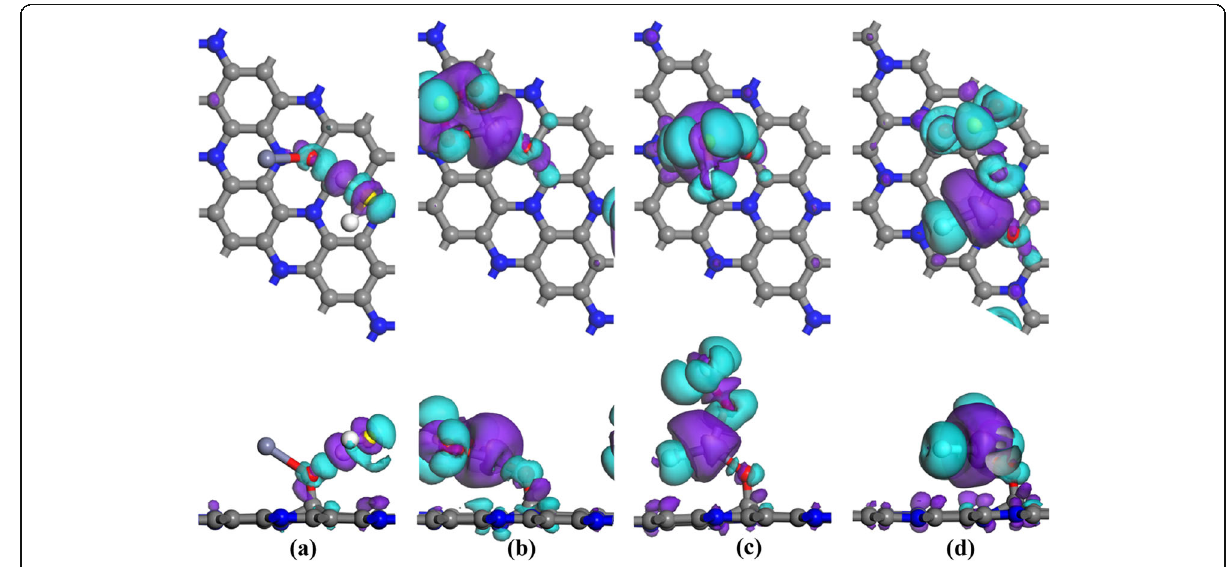
Fig. 5 The EDD of a H 2 S system, b SO 2 system, c SOF 2 system, and d SO 2 F 2